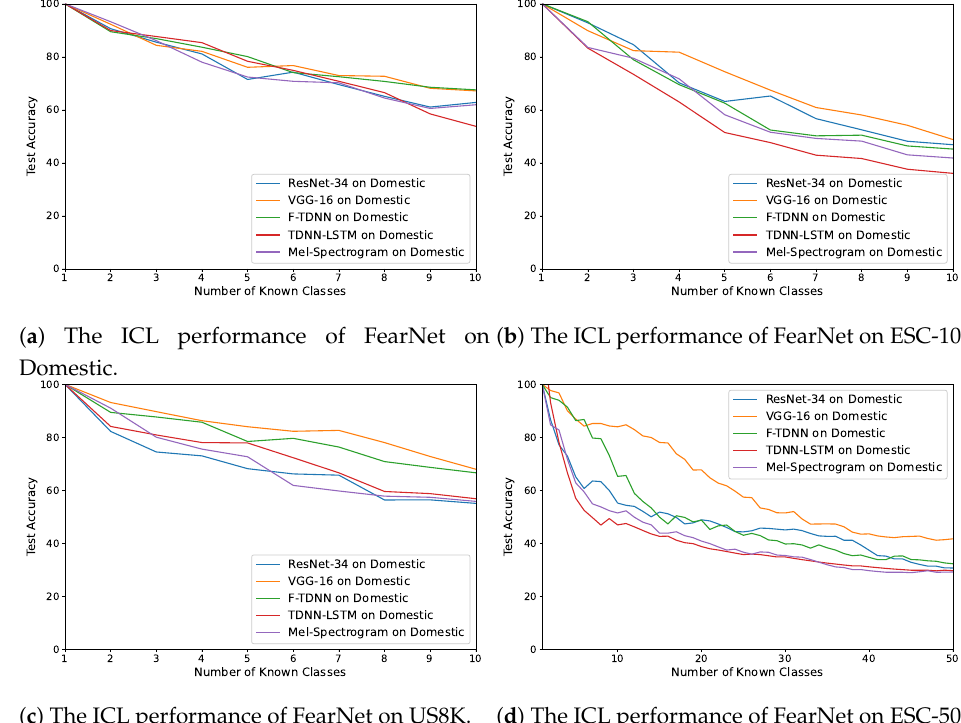
Figure 6. The average accuracy changes while incrementally learning new classes by FearNet on the datasets: ( a ) Domestic, ( b ) ESC-10, ( c ) US8K, and ( d )